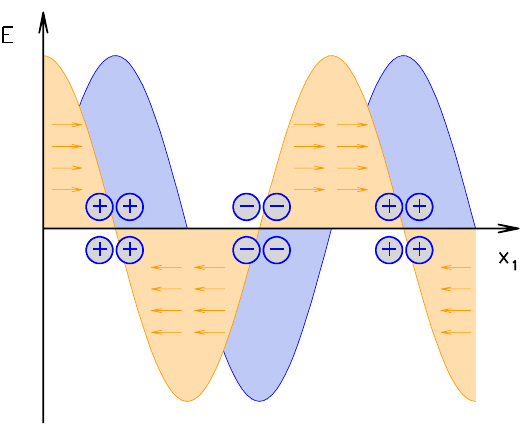
Figure 1 . Illustration of the equilibrium situation in the presence of a weak electric field E k x 1 modulated in the x 1 direction (dark yellow area and arrows). Positive (negative) electric charges accumulate at points with E = 0 pointed towards (away from) the electric field, giving rise to the charge density profile indicated by the blue